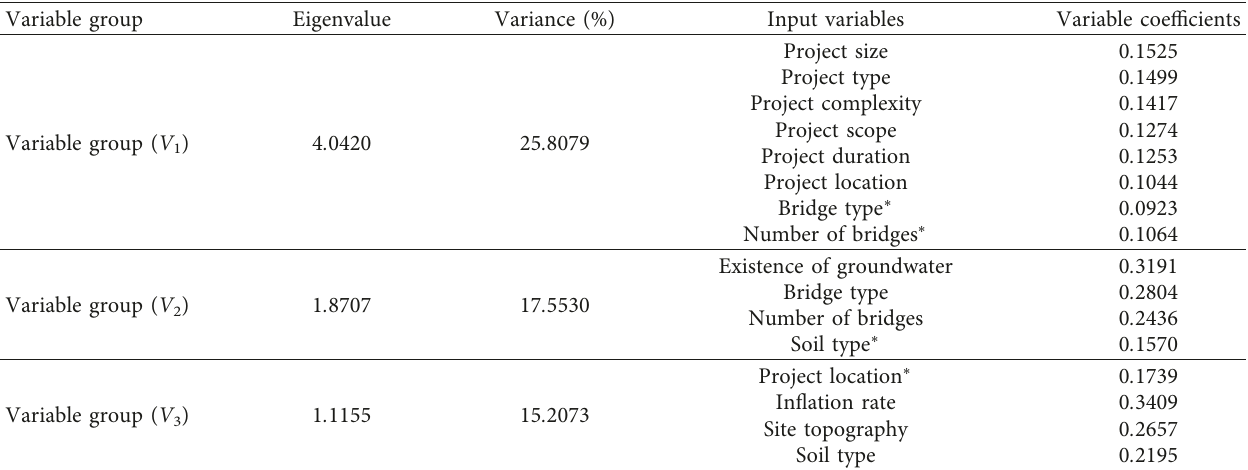
Table 3: Variable groups and coefficients.